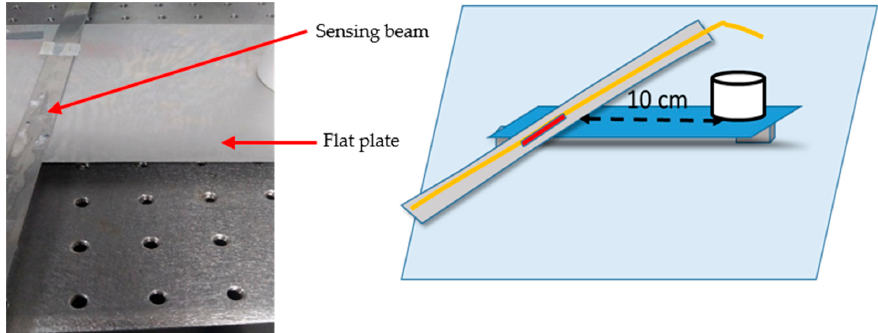
Figure 4. Experimental configuration with beam bearing the FBG placed on a thin metal plate.